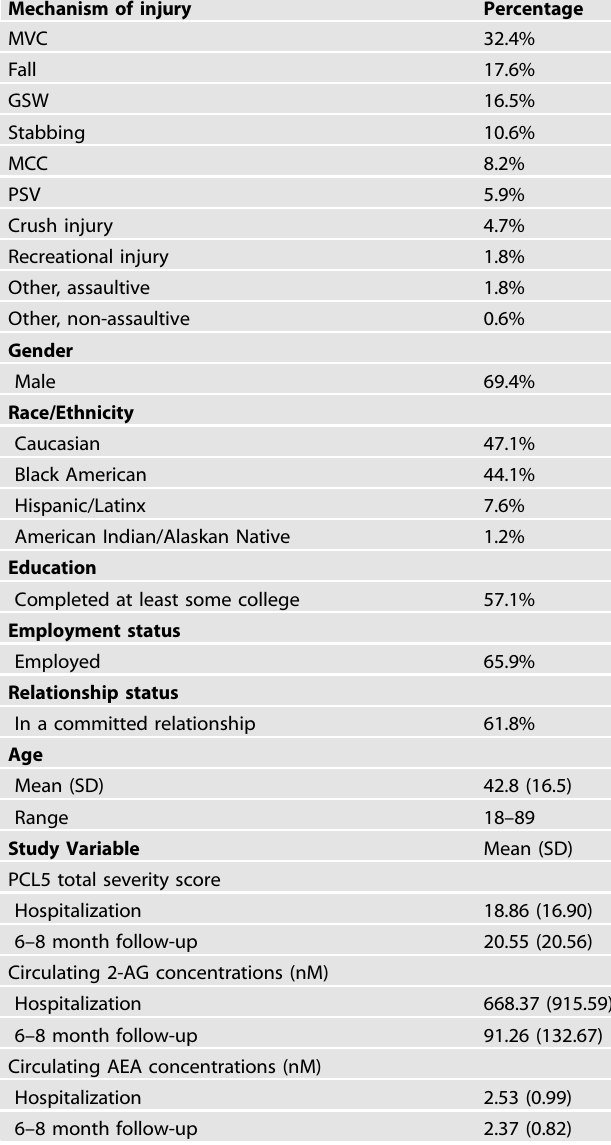
Table 1. Descriptive statistics for sample and study